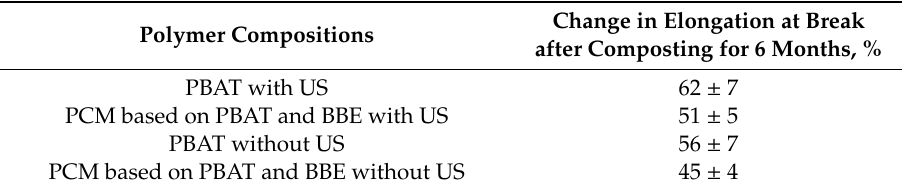
Table 7. Results of determining the degree of biodegradation of the studied PCM.